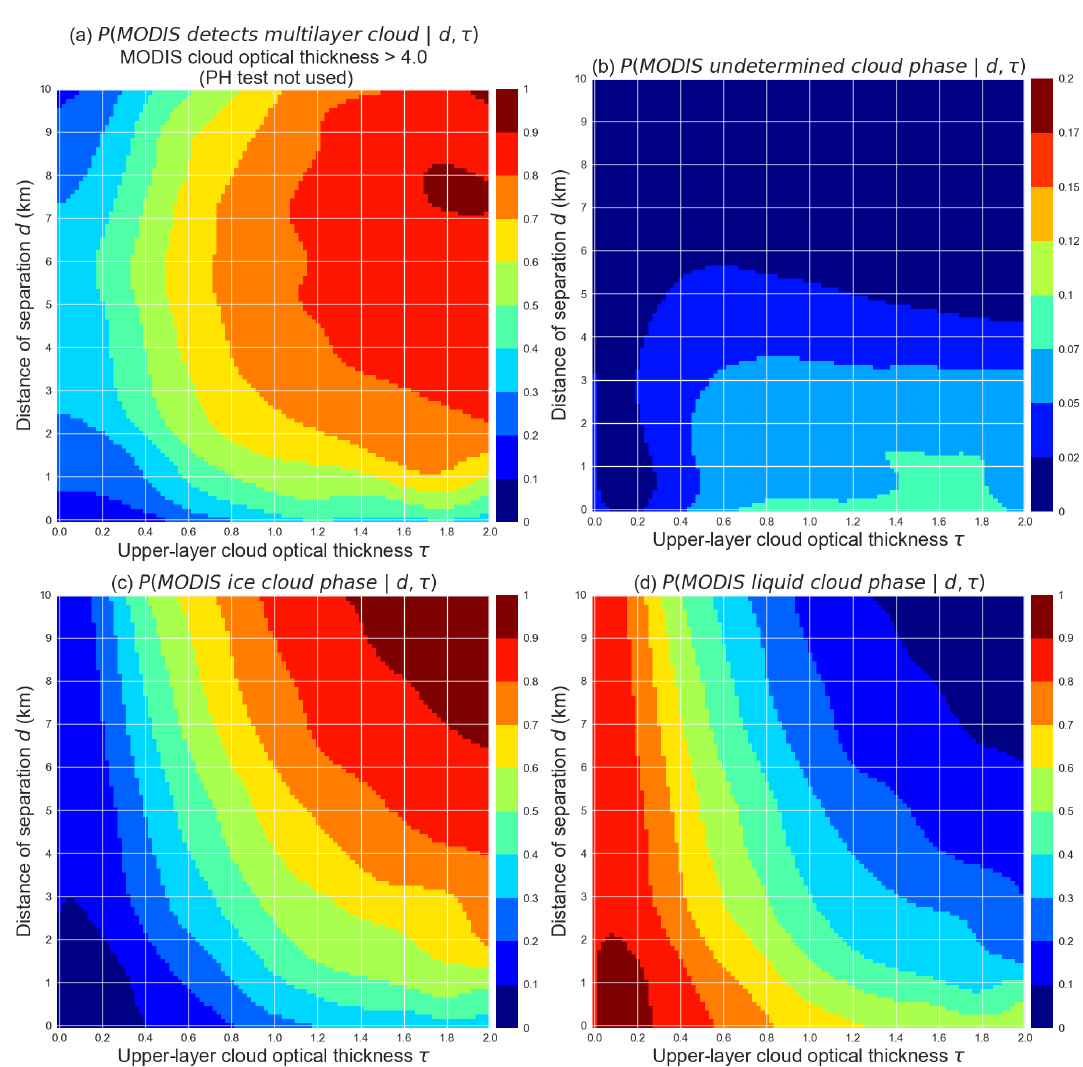
Figure 7. (a) Probability that the MYD06 multilayer cloud detection algorithm detects an ice cloud overlapping a liquid cloud (with the PH test turned off) given the separation distance ( d ) between the two cloud layers and the upper-layer cloud optical thickness ( τ ) defined by the 2B-CLDCLASS-lidar products, and probabilities that the MYD06 cloud optical properties phase algorithm provides an undetermined (b) , ice (c) or liquid (d) cloud phase given d and τ